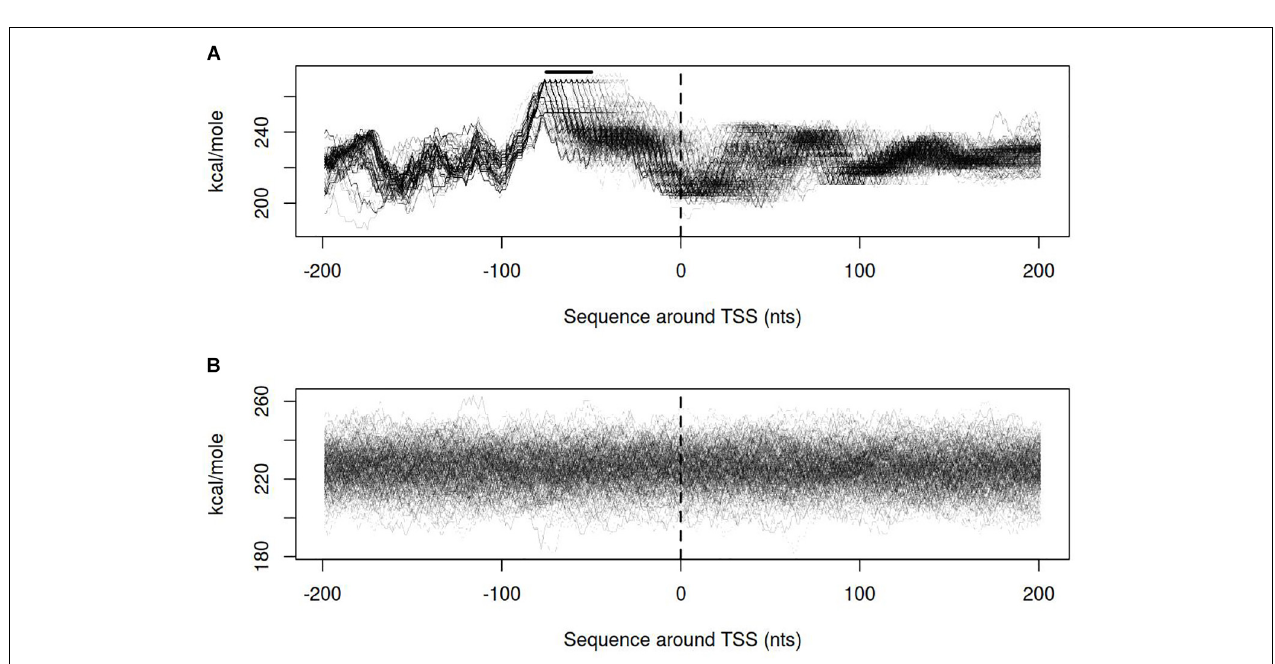
FIGURE 7 | Open states activation energy profiles for (A) vlhA promoters of 12 M. gallisepticum strains; (B) sigma 70 promoters of S6 strain. Dashed line denotes transcription start site; solid horizontal line – approximate GAA repeats location.